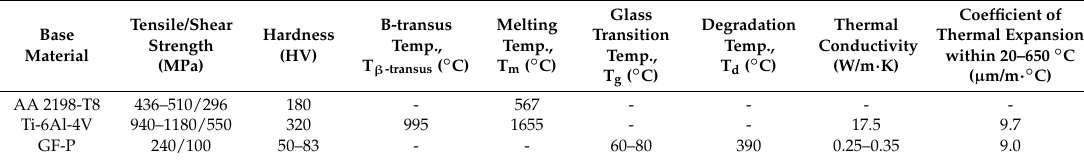
Table 2. Selected thermal and mechanical properties of AA 2198-T8 [23], Ti-6Al-4V alloy [24] and